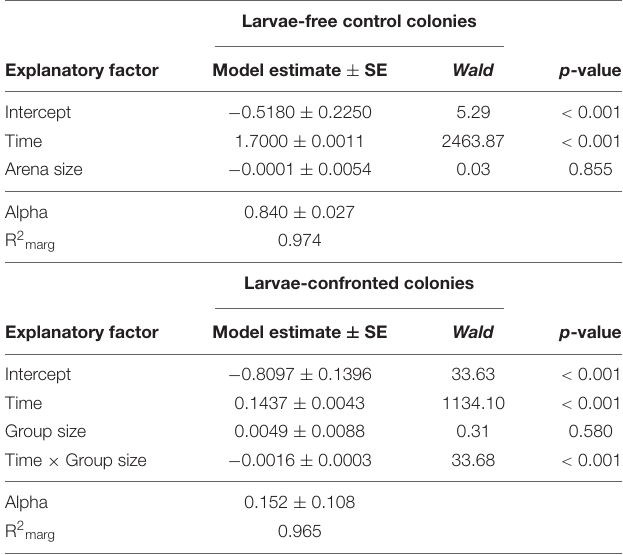
TABLE 1 | Factors influencing expansion of Aspergillus nidulans in Experiment 1. Results of the most parsimonious GEE model (after backward elimination of non-significant factors) for larvae-free and larvae-confrontedfungal colonies are